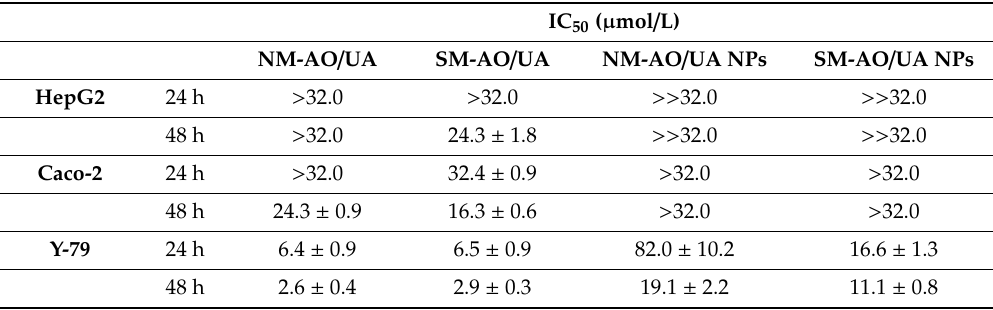
Table 1. The values of IC 50 ( µ mol / L), (half maximal inhibitory concentration) obtained for HepG2, Caco-2 and Y-79 cells exposed NM-OA / UA, SM-OA / UA, NM-OA / UA NPs and SM-OA / UA NPs. The results are expressed as the mean ± SD, n = 4. IC 50 ( µ mol / L) NM-AO / UA SM-AO / UA >